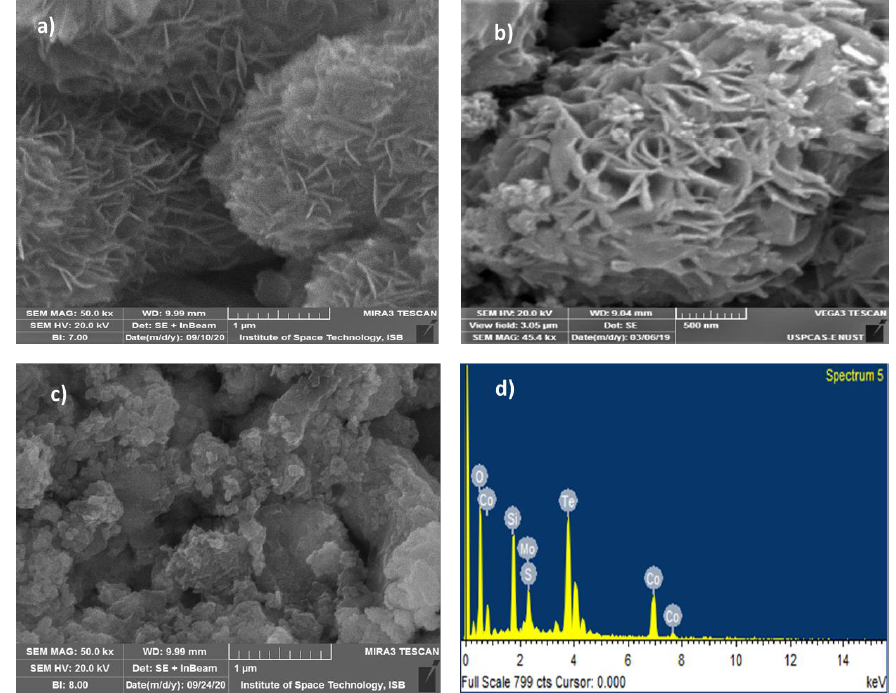
Figure 2. SEM images of ( a ) MoS 2 at 1 µ m, ( b ) 1:1 MC at 500 nm, ( c ) CoTe at 1 µ m, ( d ) EDS spectra of 1:1 MC.